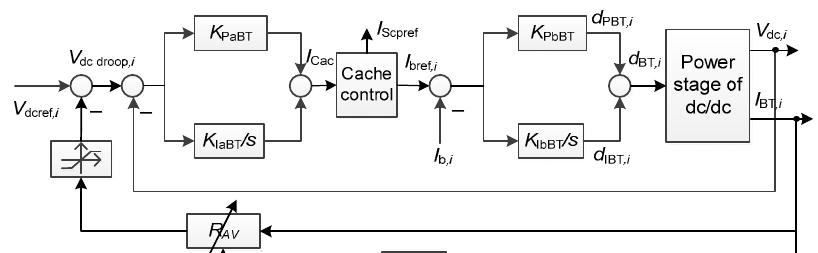
Figure 4. Control diagram of the i th BESS.